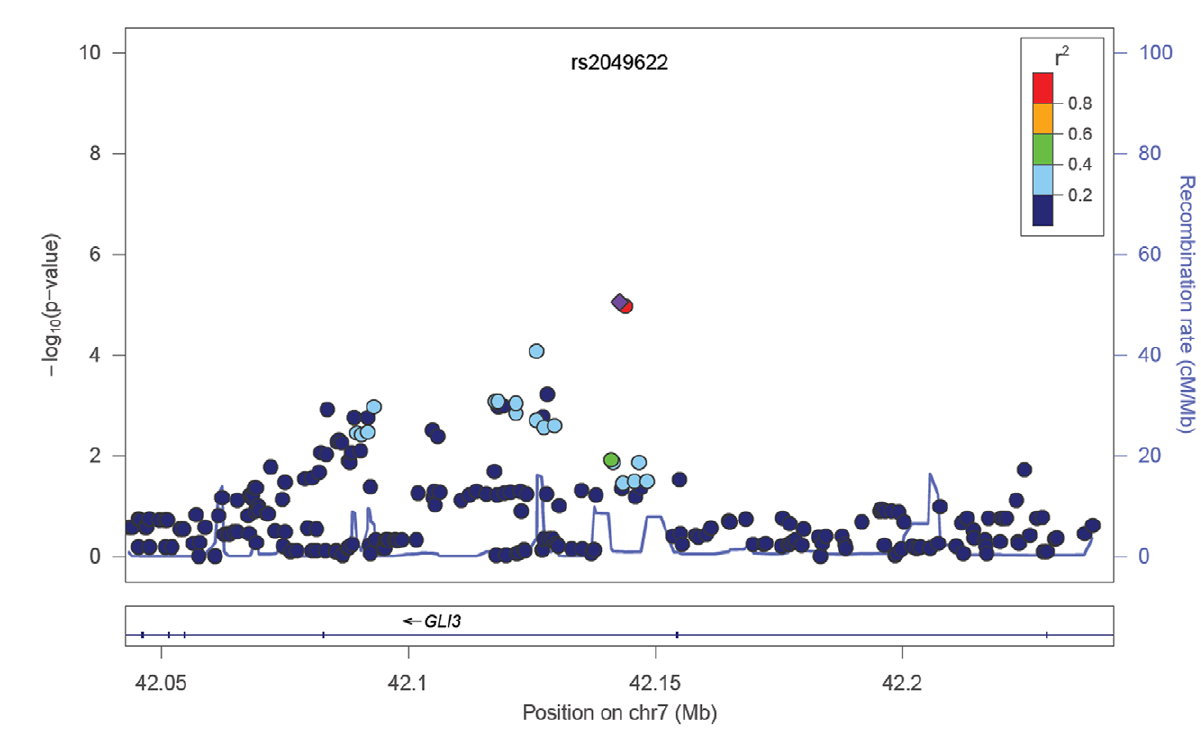
Figure 1. Regional association results for chromosome 7 SNPs in the GLI -Kruppel family member GLI3 gene. The index, associated SNP is named and shown as a purple diamond (rs2049622: P =8.9 6 10 2 6 ); remaining SNPs are colored according to the strength of LD ( r 2 ) with the index SNP (see figure legend). Pairwise LD and local recombination rates were calculated using HapMap CEU population data (Phase 2, release # 22), with annotated genes mapped according to NCBI Build 36 sequence position.